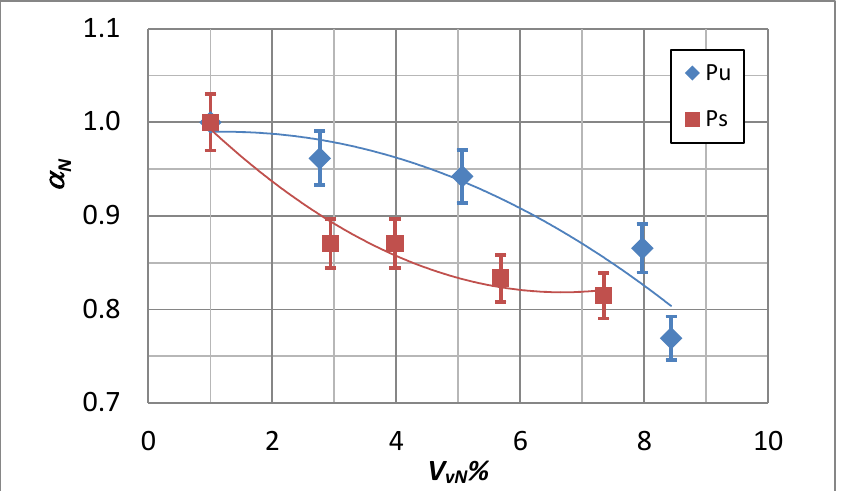
Figure 9. Normalized average thermal diffusivity, coupon type plots.